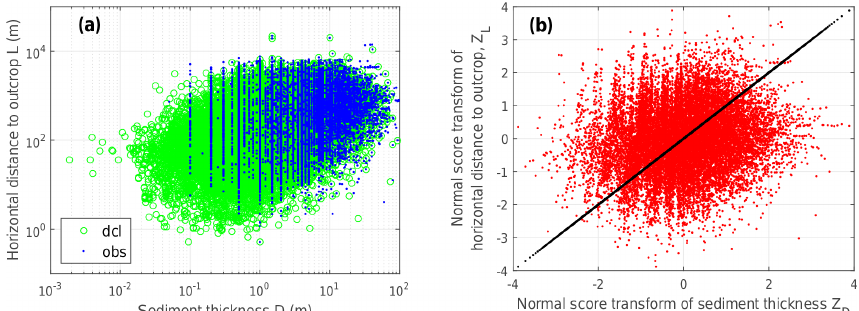
Figure 4. Scatter plot of sediment thickness D and horizontal distance to outcrop L . Original (obs) and declustered (dcl) observations to the left (a) , and normal score transforms Z D and Z L to the right (b) . The black line indicates a “perfect” ( 1 : 1 ) relation between Z D and Z L .